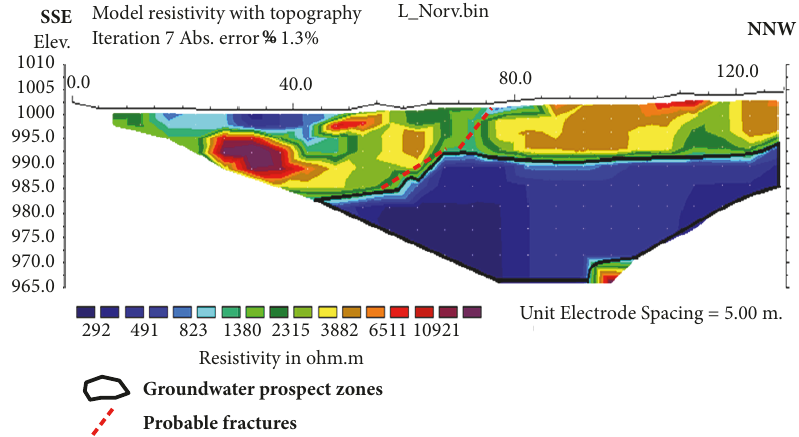
Figure 7: Inverse resistivity model along profile 4.